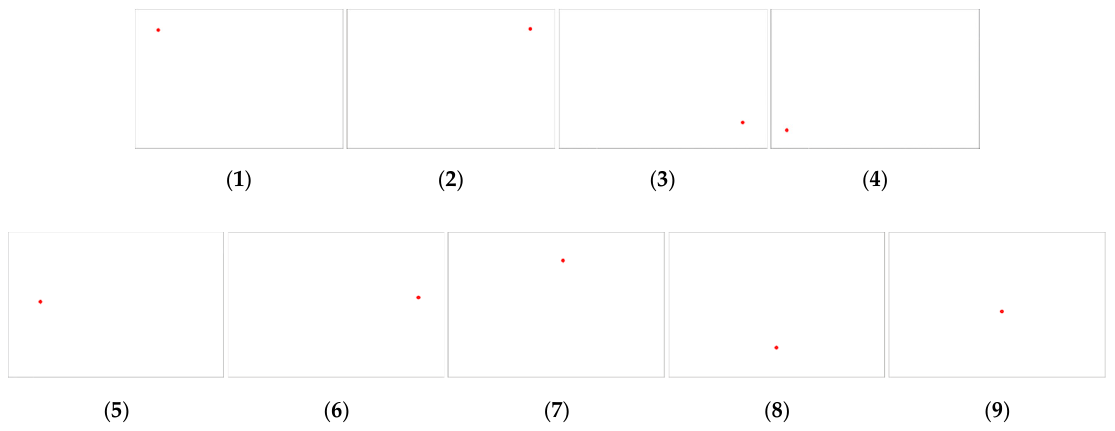
Figure 16. Experiment 1 for proposed system and algorithm verification ( 1 ) when pressing the upper left corner ( 2 ) when pressing the upper right corner ( 3 ) when pressing the bottom right corner ( 4 ) when pressing the bottom left corner ( 5 ) when pressing the left ( 6 ) when pressing the right ( 7 ) when pressing the upper ( 8 ) when pressing the bottom ( 9 ) when pressing the